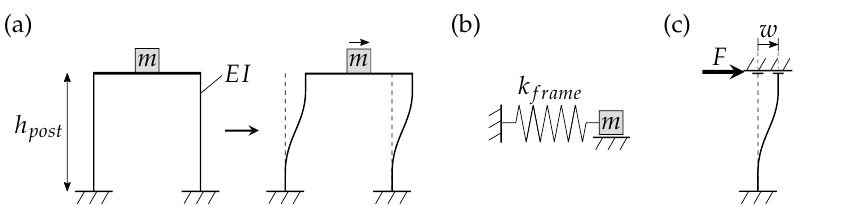
Figure 9. A frame composed of four elastic posts with the height h post and the bending stiffness EI and a rigid bar with a mass m that can only move horizontally is displayed in ( a ). It is abstracted as a SDOF spring-mass system with the spring k frame ( b ). The applied force F leads to the deflection w ( c ). The sketches are based on [22].